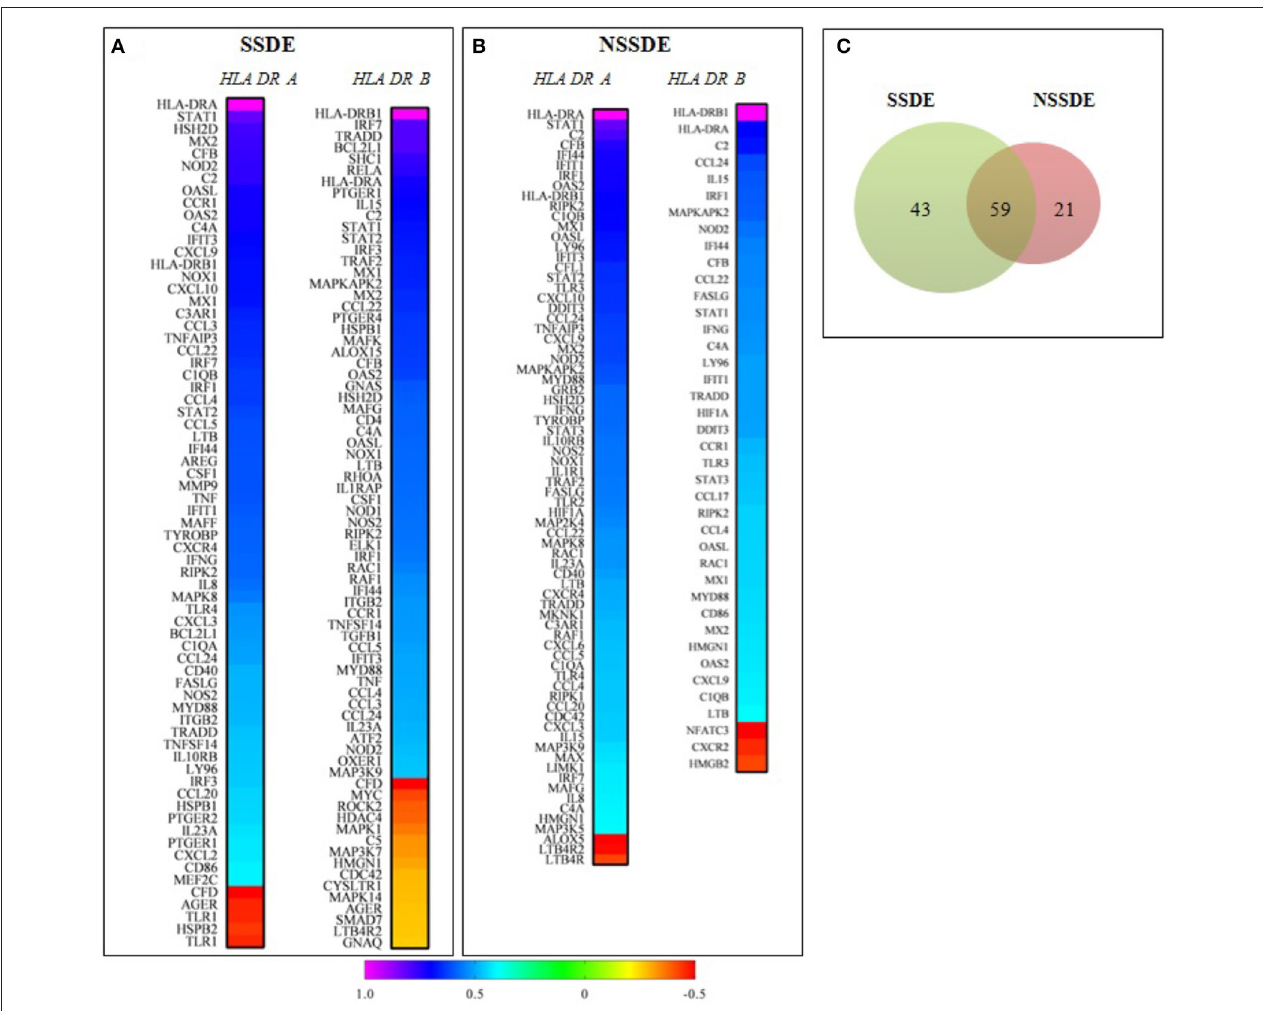
FIGURE 2 | Correlation analysis of genes with HLA-DRA and HLA-DRB1 based on the Spearman’s correlation coefficients of genes in SSDE and NSSDE patients. (A,B) Represent Heat Map of genes significantly ( P < 0.05) correlated with both HLA-DR-A and HLA-DRB1 , in a descending manner. (C) Venn diagram showing the number of specific and common targets identified in the two groups of patients. SSDE, syndrome Sjögren dry eye; NSSDE, non syndrome Sjögren dry